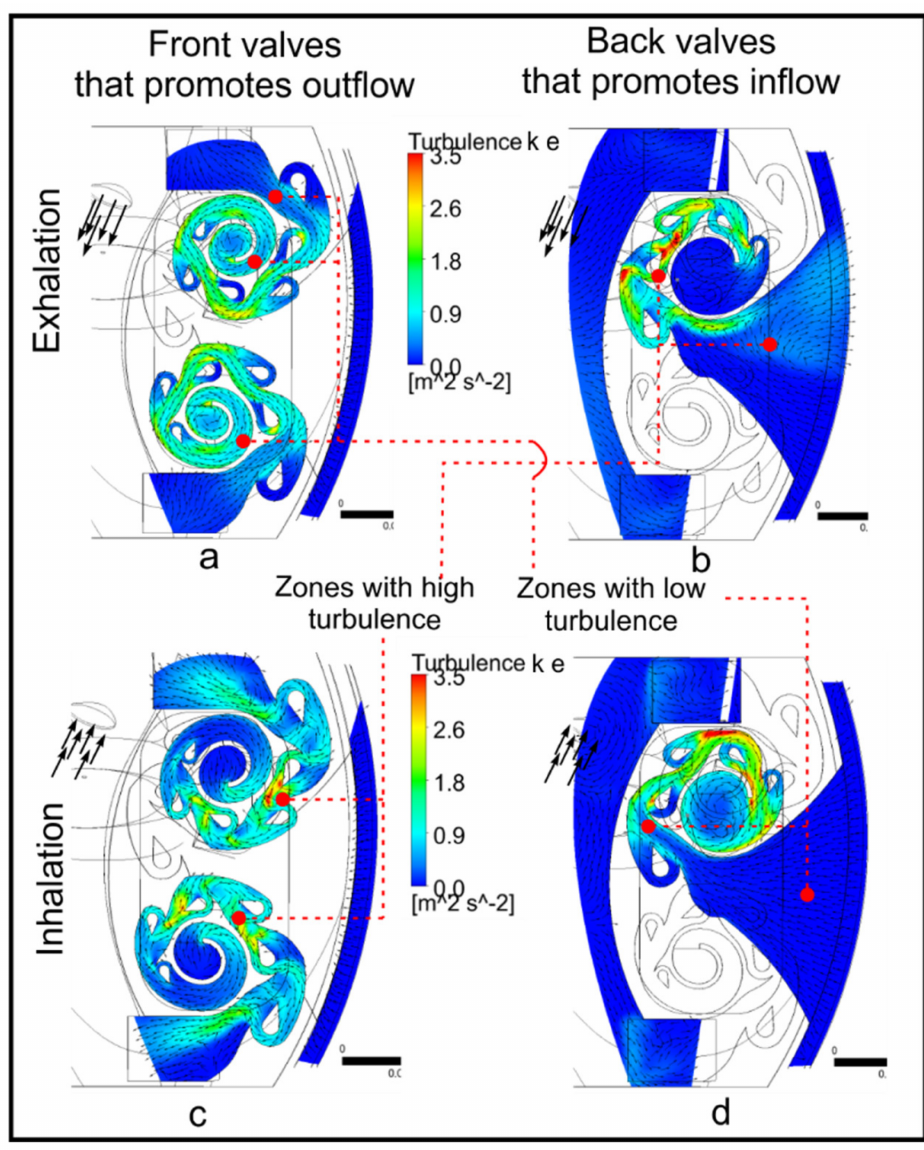
Figure 9. Contours of turbulence Kinect energy into the valves. ( a , d ) show zones with low turbulence in the valves for exhalation and inhalation events, respectively. ( b , c ) show zones with high turbulence due to baffles for the exhalation and inhalation events,